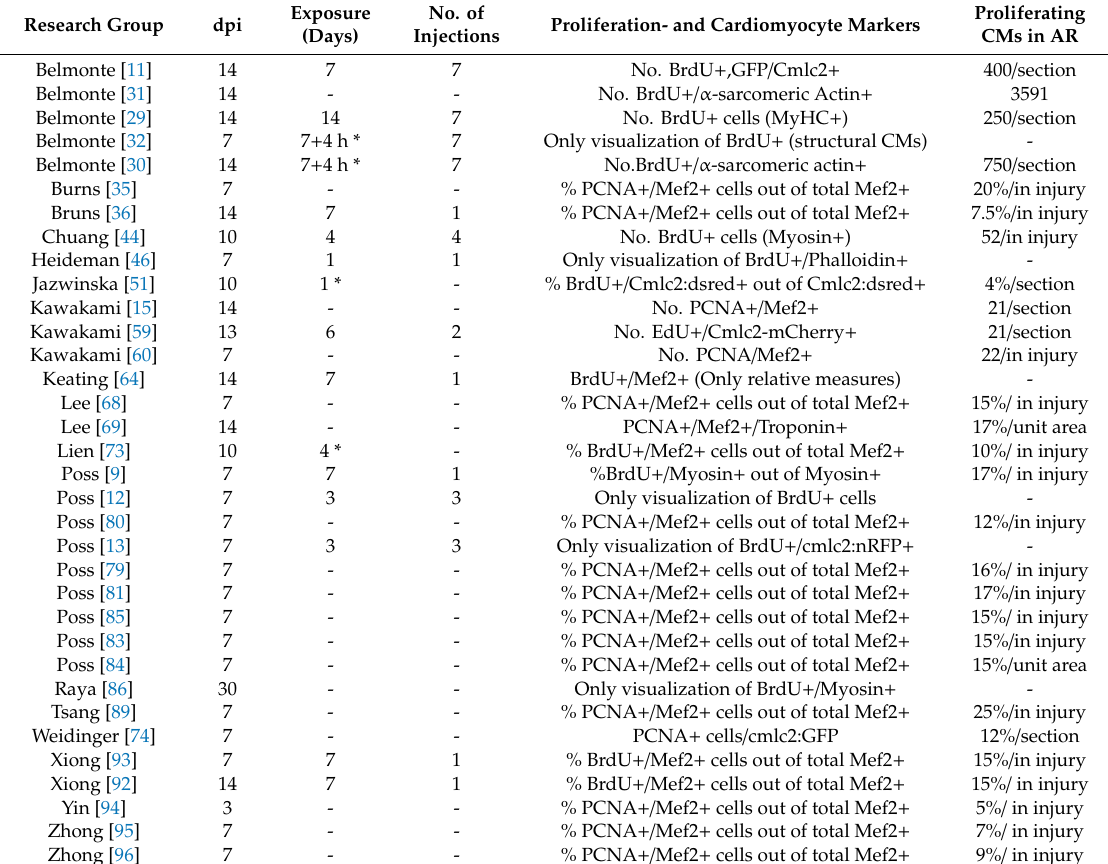
Table 5. Overview of design and reporting manners for cardiomyocyte proliferation studies after Apex resection (AR) in